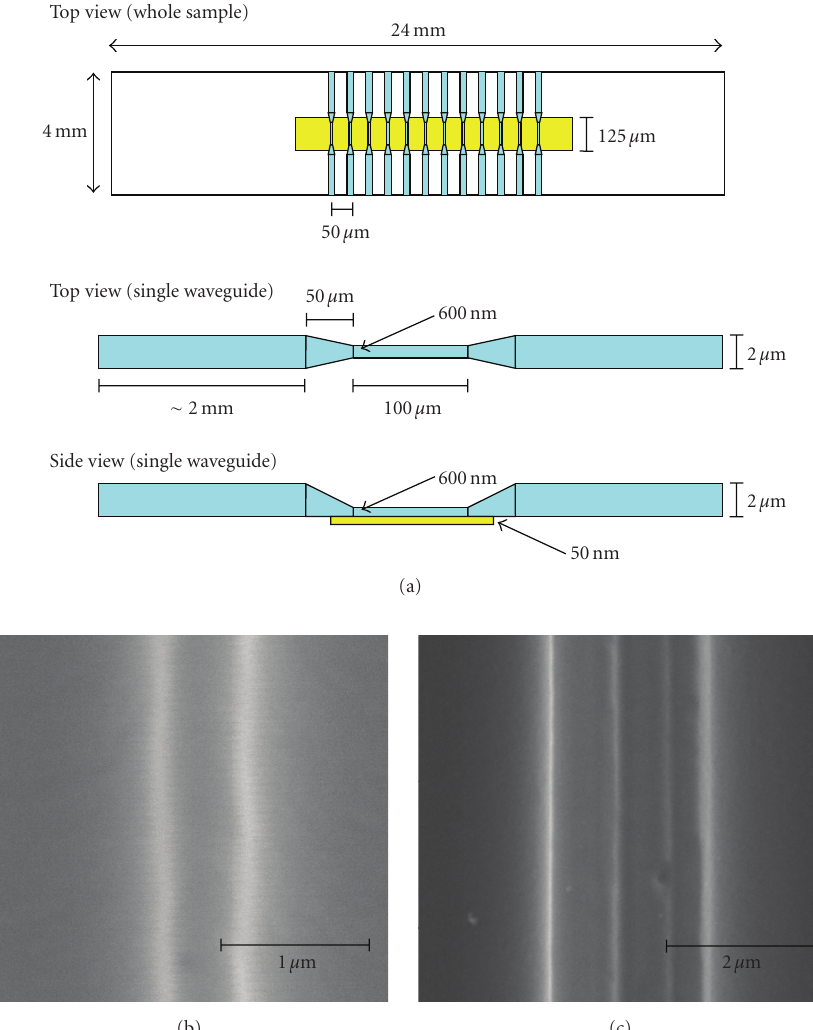
Figure 1: (a) A schema showing the layout of a sample with plasmonic waveguides. The waveguides consist of optical waveguides at either end which taper down to a 100micrometer long plasmonic waveguide only 600nm wide. (b) SEM image of the DLSPPW section. (c) SEM image of the optical waveguide